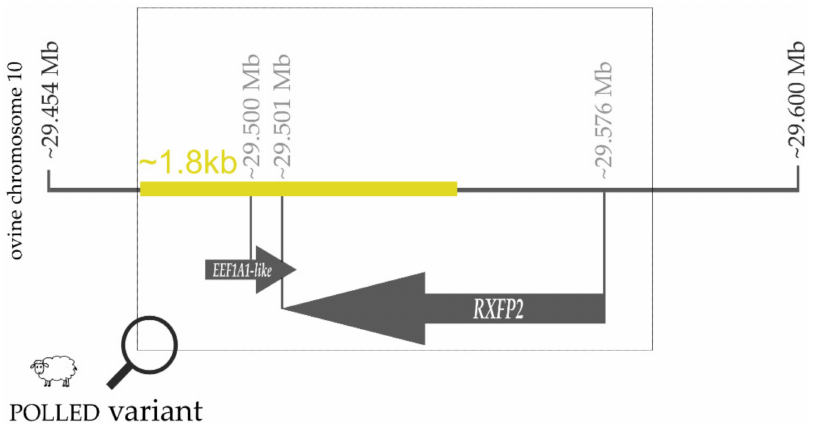
Figure 7. Schematic representation of the polledness-associated insertion variant in sheep in the 3 (cid:48) UTR region of the RXFP2 gene on chromosome 10. The coordinates refer to the current reference genome ARS-UI_Ramb_v2.0 of the sheep. Note that this variant is not associated with polledness in breeds with a sex-linked or variable horn